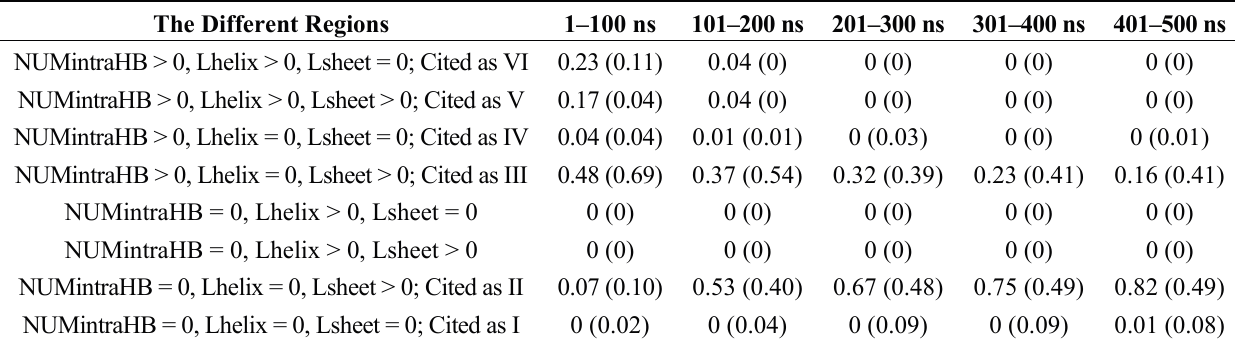
Table 3. The respective probabilities for the α -syn12 dimer fall within different regions at the different pH values and simulation times. The results at the acidic pH are shown in the brackets.